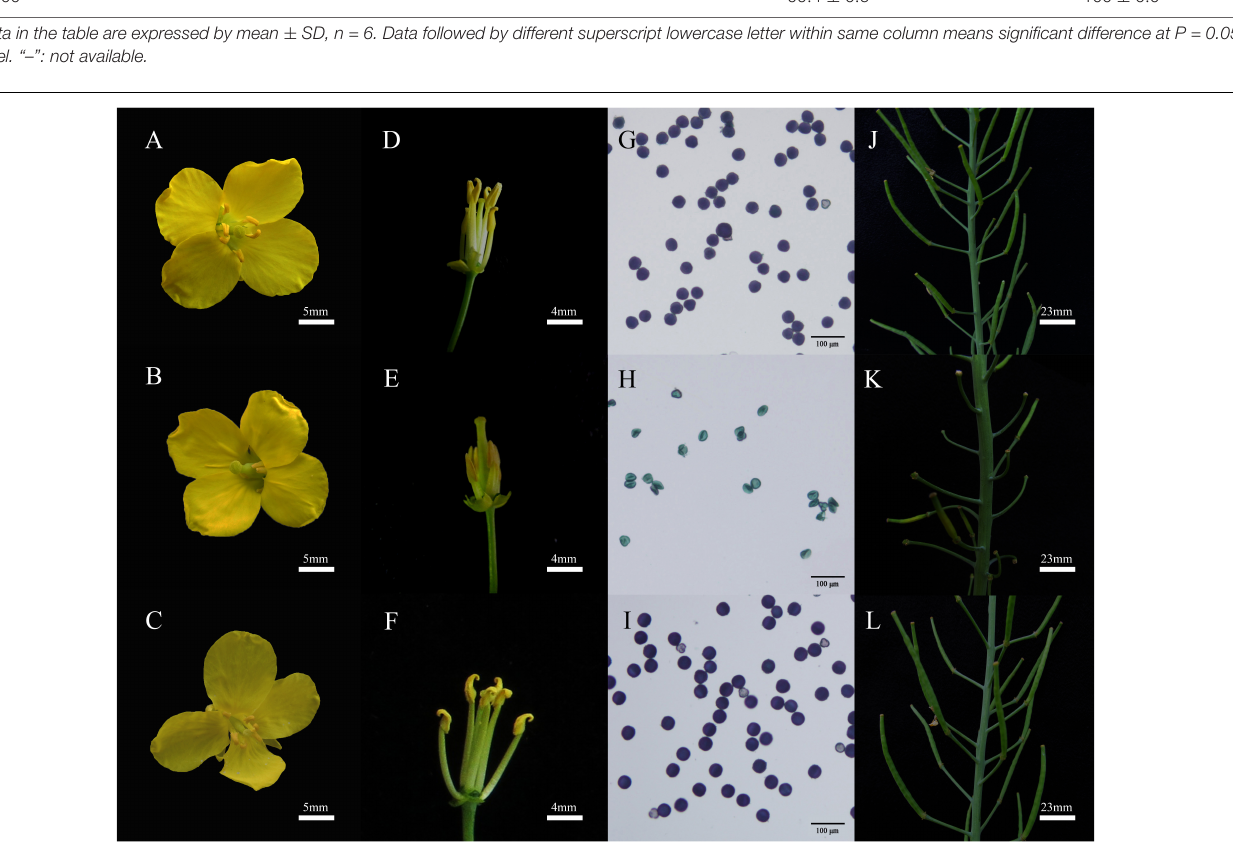
FIGURE 2 | Phenotype of rapeseed ZS9 and mutant line K5 treated with tribenuron-methly (TBM). (A,D) Photograph of flower from ZS9 plants treated with 0 mg · L − 1 TBM. (B,E) Photograph of flower from ZS9 plants treated with 0.10 mg · L − 1 TBM. (C,F) Photograph of flower from K5 plants treated with 0.10 mg · L − 1 TBM. (G–I) Pollens viability of ZS9 plants treated with 0 mg · L − 1 TBM (G) and with 0.10 mg · L − 1 TBM (H) , and K5 plants treated with 0.10 mg · L − 1 TBM (I) , respectively (bars = 100 µ m). (J–L) Seed setting of ZS9 plants with 0 mg · L − 1 TBM (J) , ZS9 (K) , and K5 (L) plants treated with 0.10 mg · L − 1 TBM by bag-selfing,